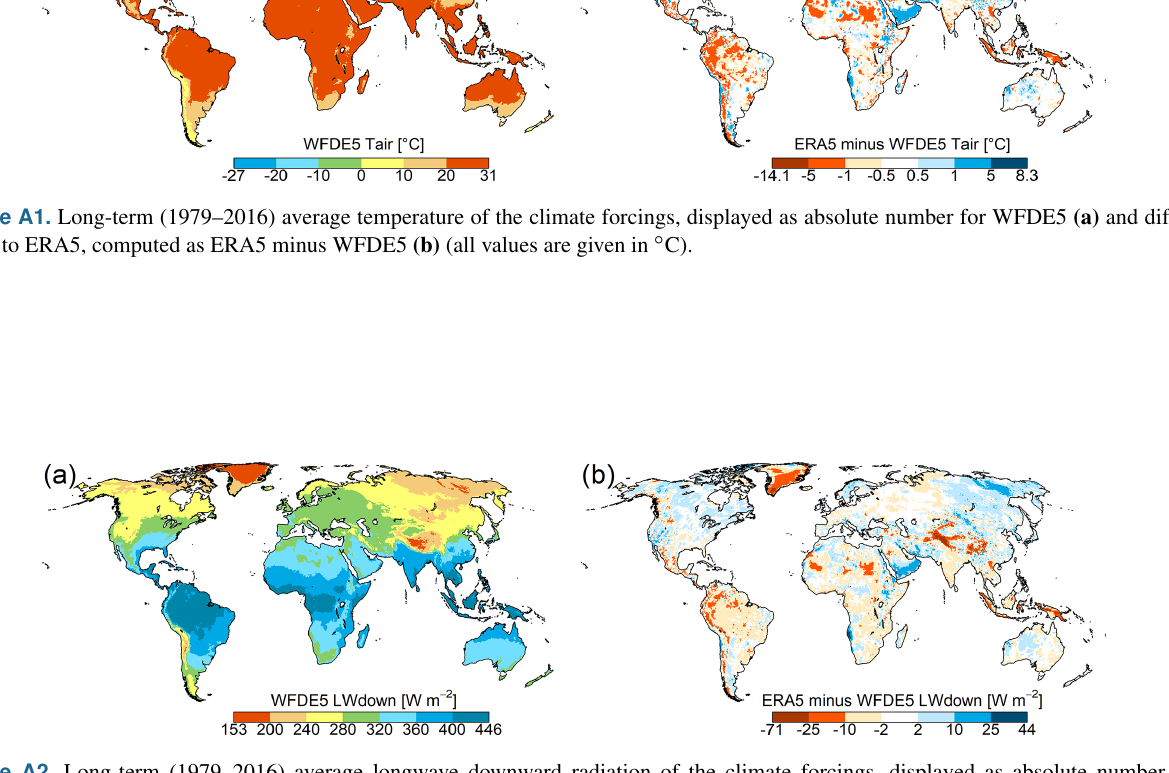
Figure A2. Long-term (1979–2016) average longwave downward radiation of the climate forcings, displayed as absolute number for WFDE5 (a) and differences to ERA5, computed as ERA5 minus WFDE5 (b) (all values are given in Wm − 2 ).